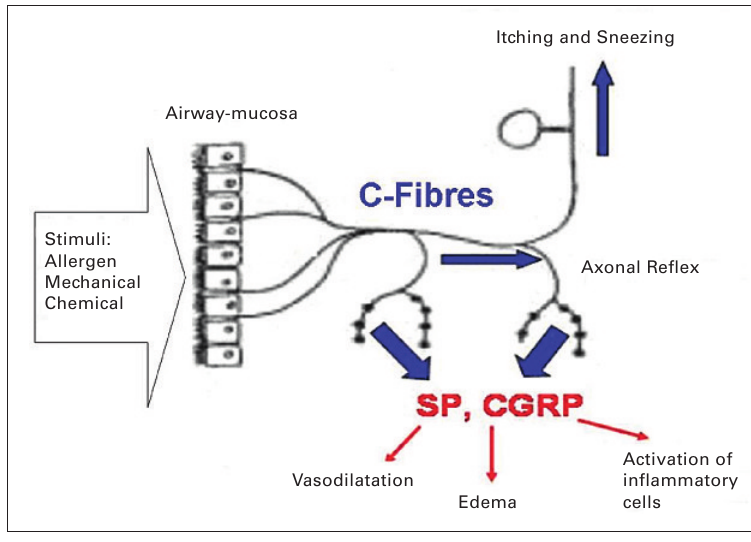
Schematic presentation of the processes involved in “neurogenic inflammation” lead- ing to itching and sneezing. Activation of afferent trigeminal C-fibres by several stimuli including allergen contact may result in an efferent liberation of substance P (SP) and calcitonin-gene related peptide (CGRP) via axonal reflex.This further leads to vasodilatation, oedema, and recruitment/migration of inflammatory cells [1, 9, 21,